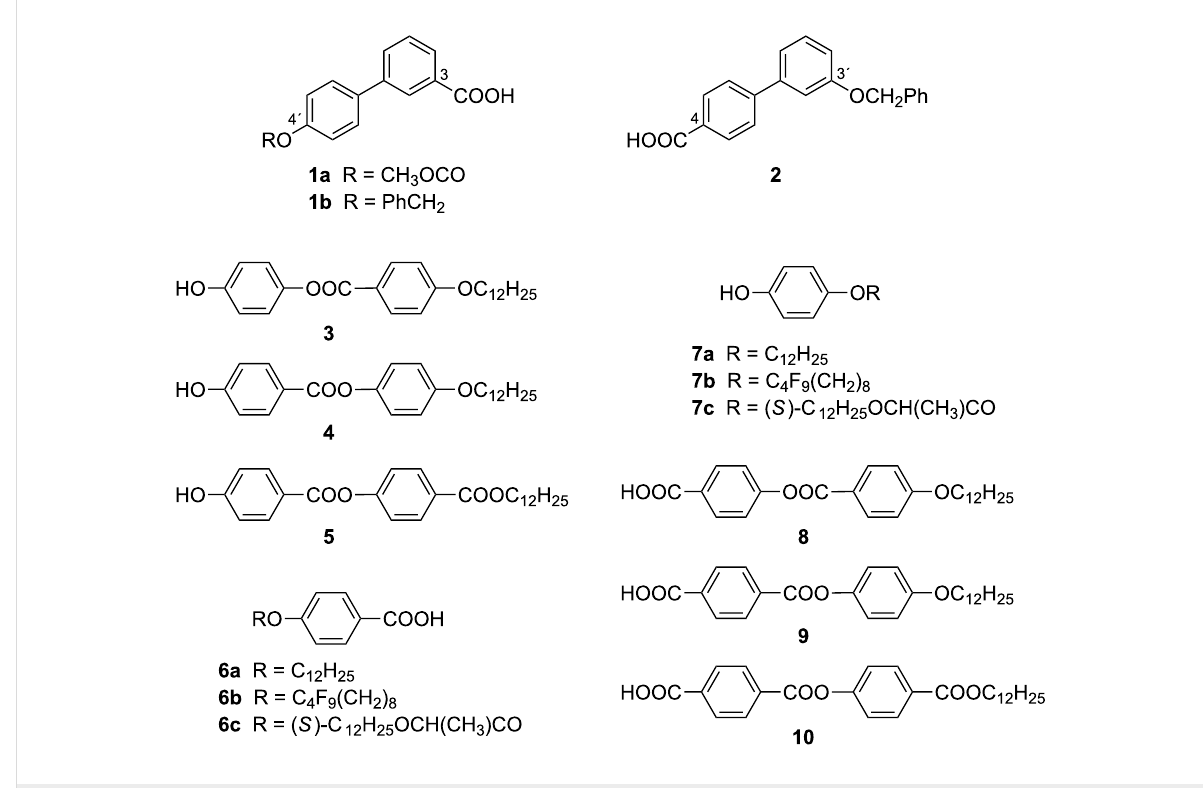
Figure 1: Structure of the central cores and lengthening arms.